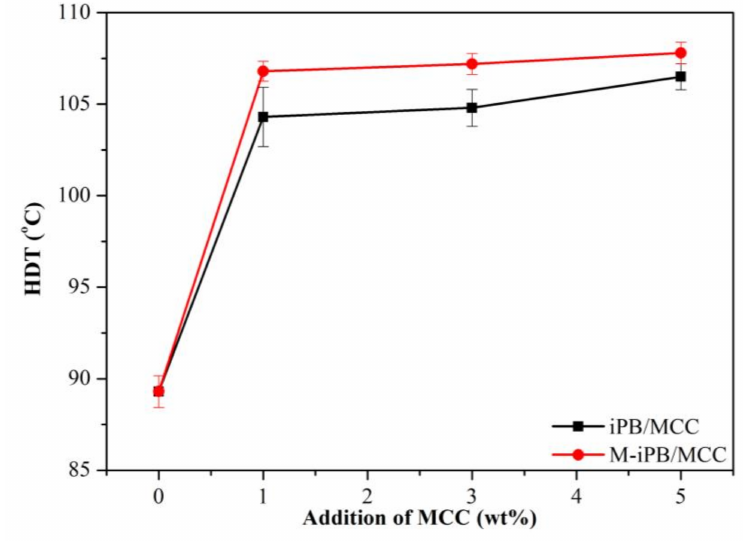
Figure 4. Heat-distortion-temperature (HDT) of iPB/MCC composites.